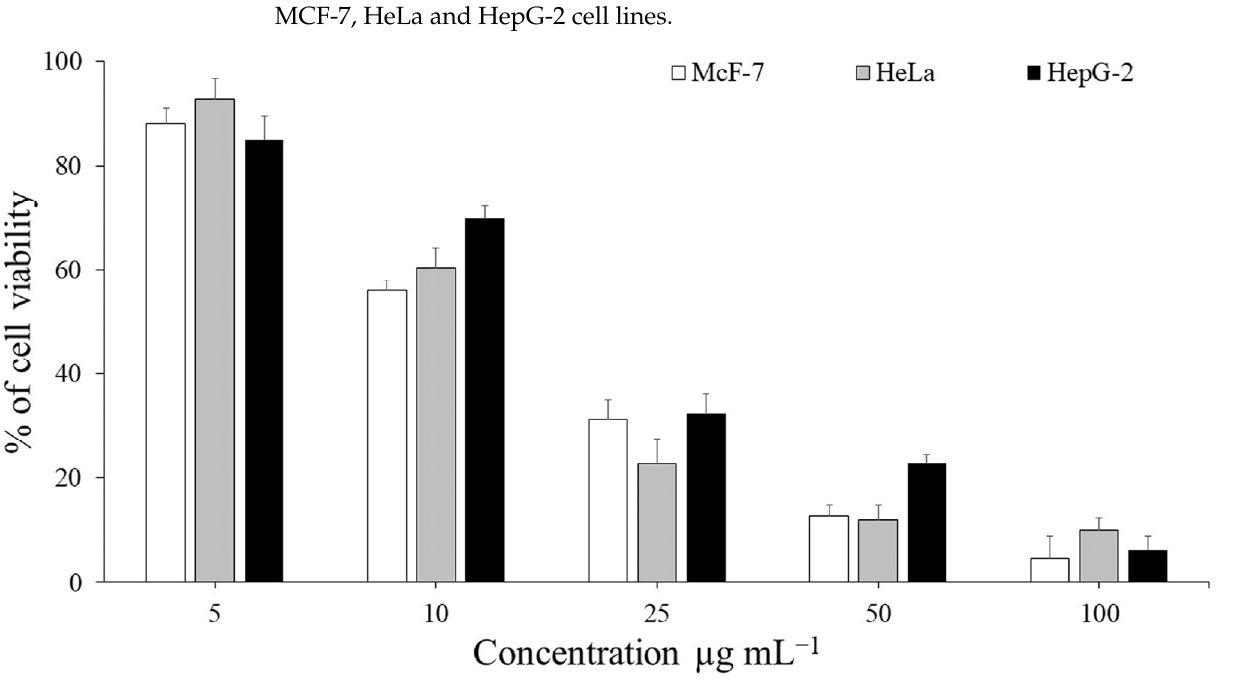
Figure 3. The in vitro cytotoxicity of EtOAc extract of P. neglecta on the viability of McF-7, HeLa and HepG-2 cell lines. Tumor cells were treated with different concentrations ranged of (5–100 µg mL − 1 ), and the cell viability was evaluated by MTT assay. The data represent the IC 50 values of 22.4, 23.2 and 28.9, respectively. The bars on the graph represent mean ± SD as a percentage of proliferation of triplicate independent experiments ( n = 3).